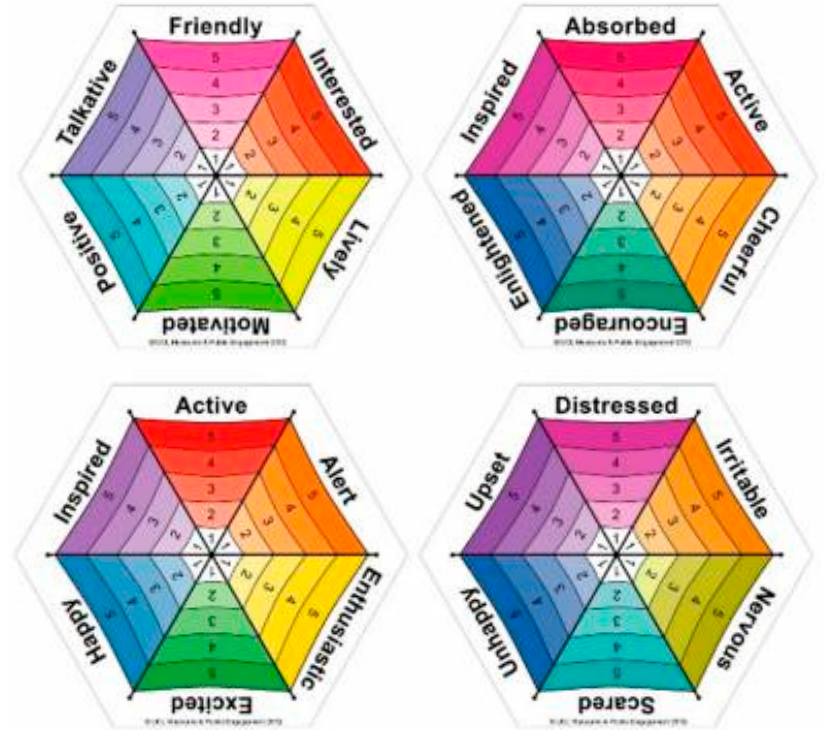
Figure 2. Museum Wellbeing Toolkit. (Thomson and Chatterjee, https://www.ucl.ac.uk/biosciences/culture-nature-health-research/ucl-creative-wellbeing-measures (accessed on 1 November 2022).